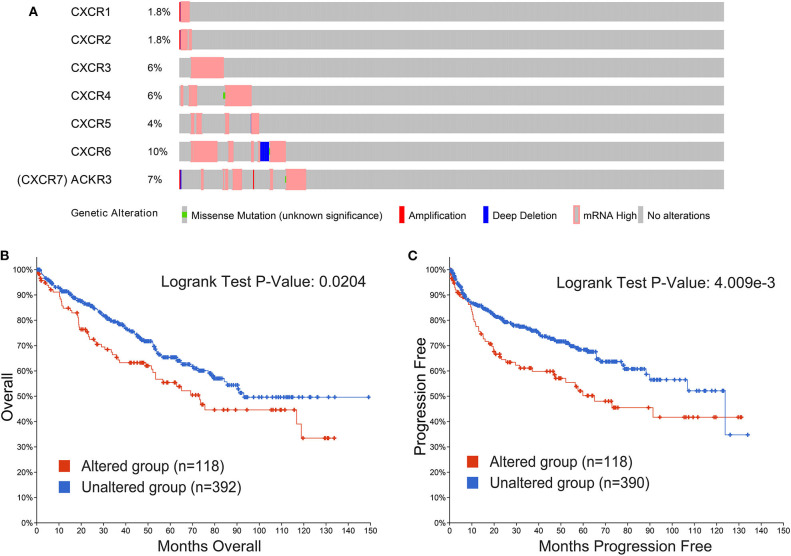
Alteration frequency of CXCRs and their correlation with overall survival (OS) and progression-free survival (PFS) of ccRCC patients. (A) The CXCRs mutation rate was 23.14% (118/510) in ccRCC patients. The top four highest mutation rates for CXCR family members were present in CXCR6 (10%), CXCR7 (CXCR7 is also called ACKR3, 7%), CXCR3 (6%), CXCR4 (6%), respectively. (B) Genetic alterations in CXCRs were significantly associated with OS of ccRCC patients (p < 0.05). (C) Genetic alterations in CXCRs were significantly related to PFS of ccRCC patients (P < 0.01).